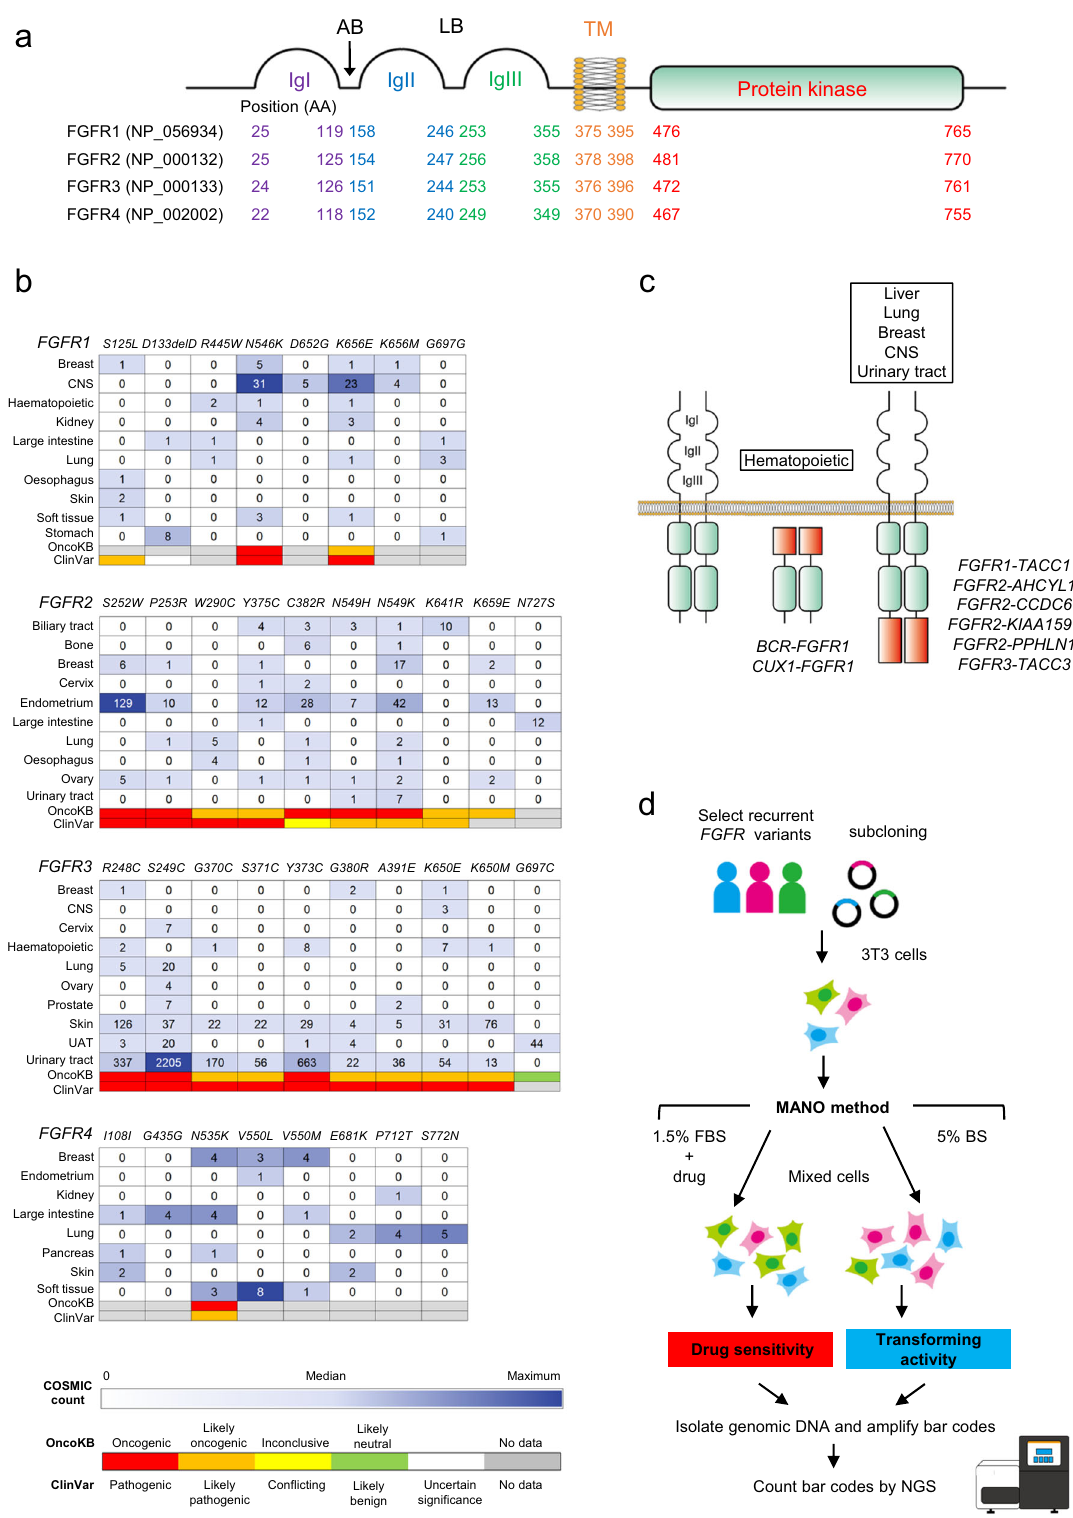
Fig. 9). The results showed concordance to those obtained through the MANO method (Supplementary Fig. 10). Hierarchical clustering analysis was conducted to evaluate the similarity of FGFR inhibitors and FGFR variants using drug sensitivity data of Fig. 4 (Supplementary Fig. 11). FGFR